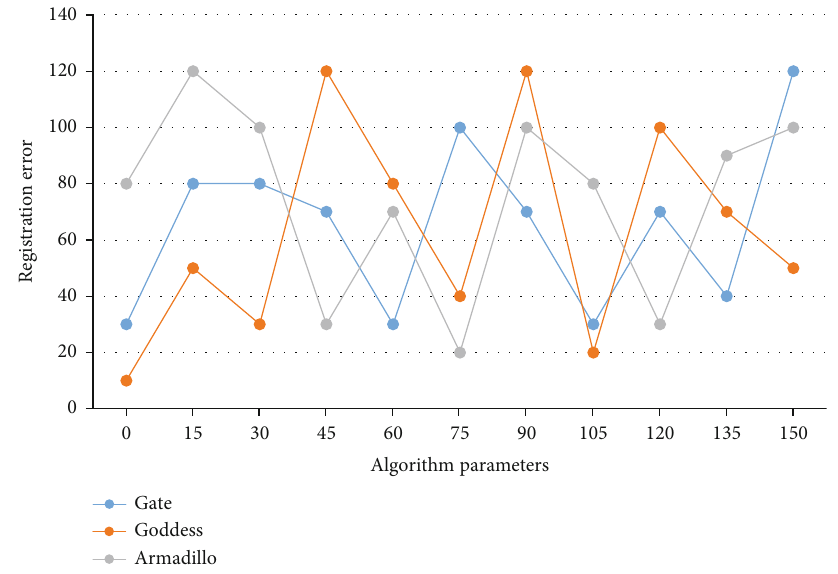
Figure 8: Bar chart of parameter comparison of multisource data point cloud algorithm. Table 1: Comparison of registration errors between SAC-IA algorithm and multisource data point cloud algorithm.